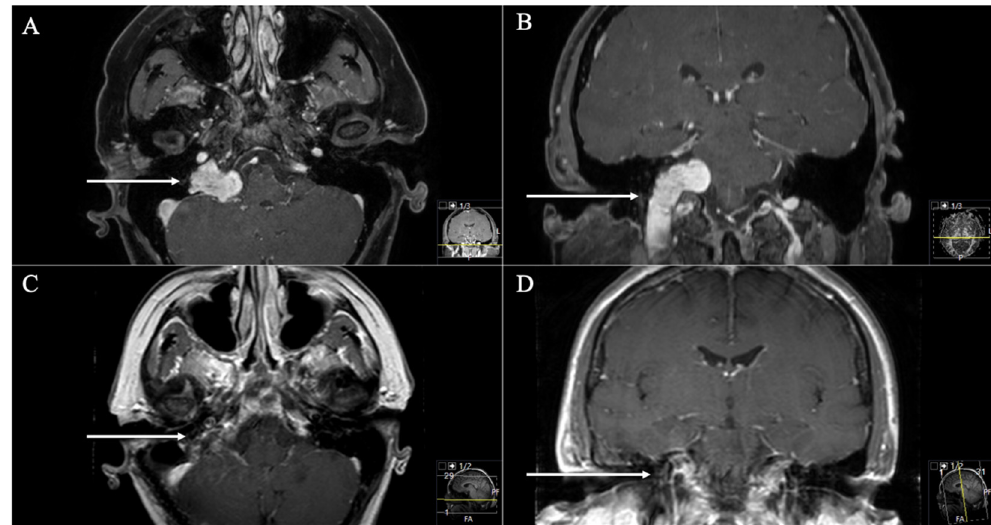
Figure 3. A 56-year-old female patient presented with headache, cerebellar dysfunctions, hearing loss, hoarseness, and extinguished gag reflex. ( A ) Preoperative axial and ( B ) coronal T1-weighted gadolinium-enhanced MRI, showing an impressive JFS (arrows) with a quasi-dumbbell shape and both intra- and extracranial components through the JF (Samii Type D). ( C ) Postoperative axial and ( D ) coronal MRI control, indicating complete resection (arrows) through a dorsolateral ELITE approach. Postoperatively, no new deficits occurred, and the patient recovered from the cerebellar dysfunctions, hoarseness, and extinguished gag reflex.